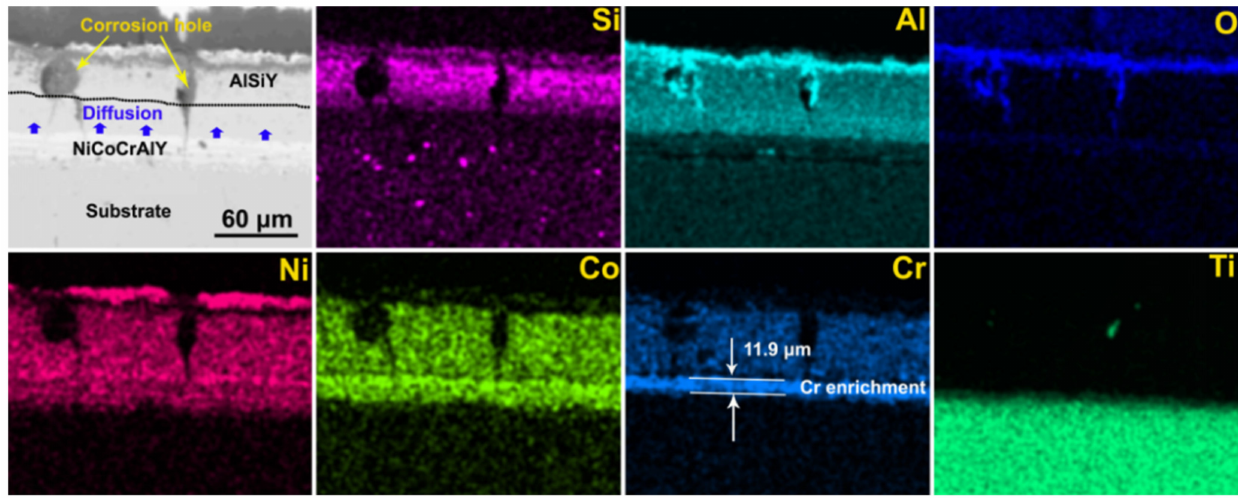
Figure 6. Cross-sectional images and element mappings of hot salt-water-corroded sample E1.